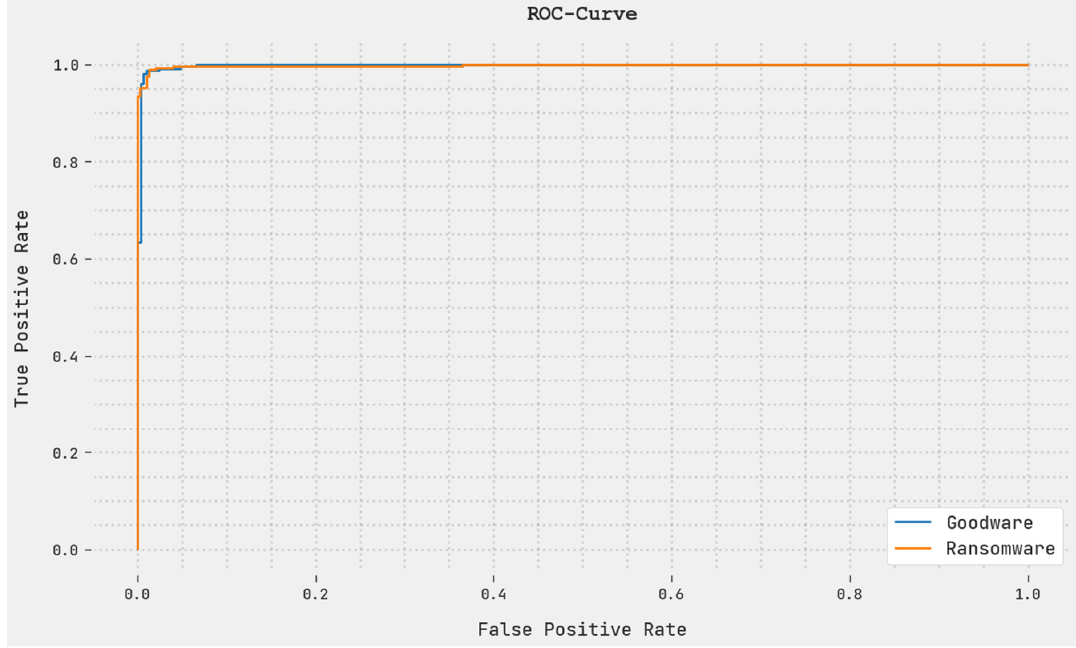
Figure 9. ROC curve analysis of DWOML-RWD approach.